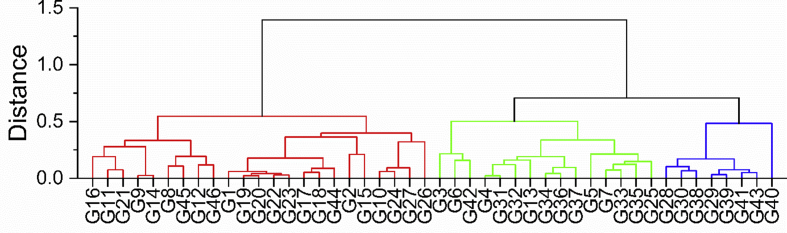
Hierarchical cluster analysis based on the specific volumes of both baking mixtures A and B. The division was made into the three quality classes “good”, “medium” and “poor”. Twenty-three vital gluten samples were classified as good (left cluster, red), 15 as medium (middle cluster, green) and eight as poor (right cluster, blue). (For interpretation of the references to colour in this figure legend, the reader is referred to the Web version of this article.)